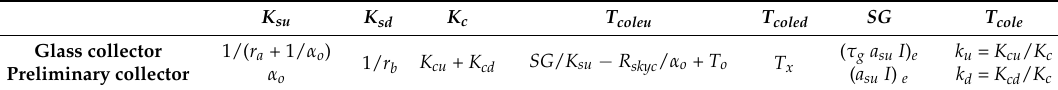
Figure 3. Air-based solar heat collector model: ( a ) preliminary collector; ( b ) glass collector. Reproduced from [33], publisher: 2019. Table 5. Parameters used in air-based solar heat collector calculations. Reproduced from [33], publisher: 2019.